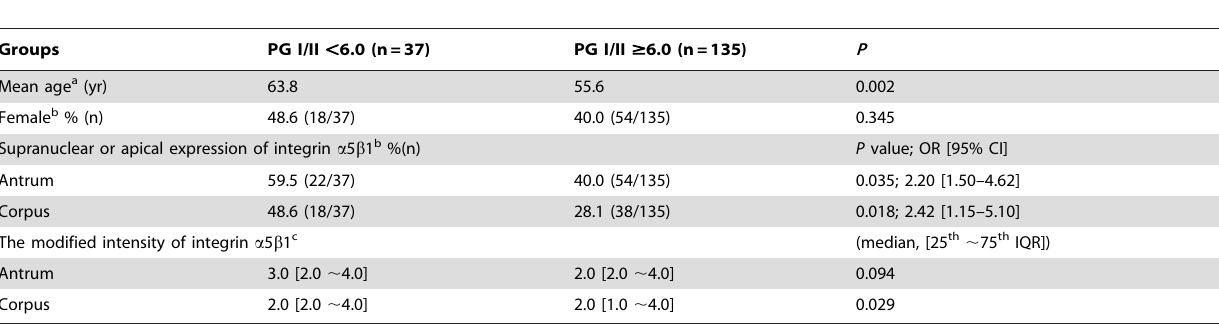
Table 2. The higher integrin a 5 b 1 expression in the H. pylori -infected patients with the serum pepsinogen I/II ratio , 6.0.